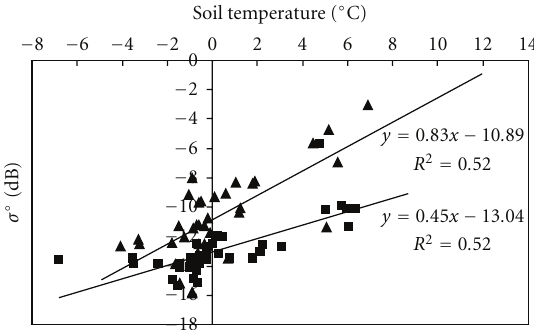
Figure 4: Linear regression models between backscattering coe ffi - cient, σ ◦ , with ground measured soil temperature (0–5 cm depth) for tilled fields (triangle) and untilled fields